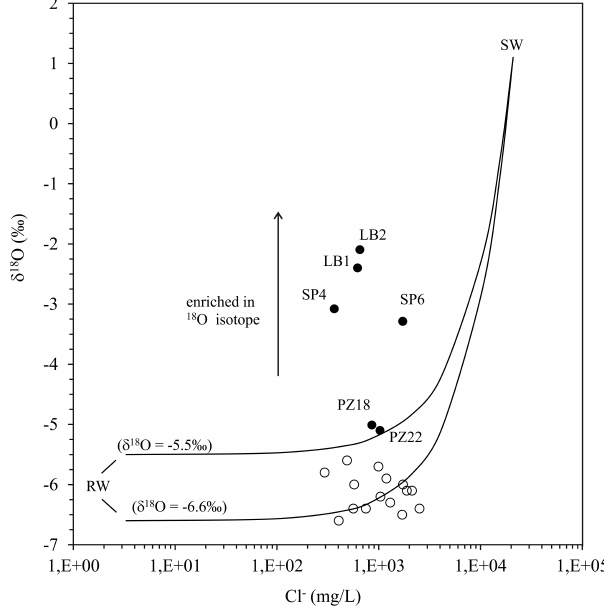
Fig. 6. δ 18 O vs. Cl . mixing lines between values of rainwater ( − 5.5‰, this work, and − 6.6‰, mean value by Celle et al., 2004) and seawater (SW, this work) are shown. The symbols are as in Fig.